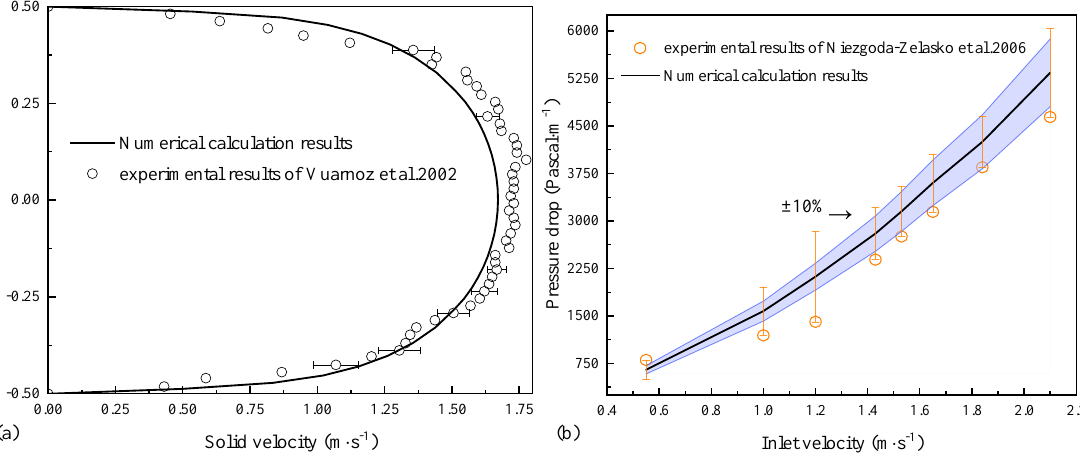
Figure 5. ( a ) Comparison of the solid velocity profile of ice slurry with experimental results of Vuarnoz. ( b ) Comparison of pressure drop of ice slurry with experimental results of Niezgoda-Zelasko [15].